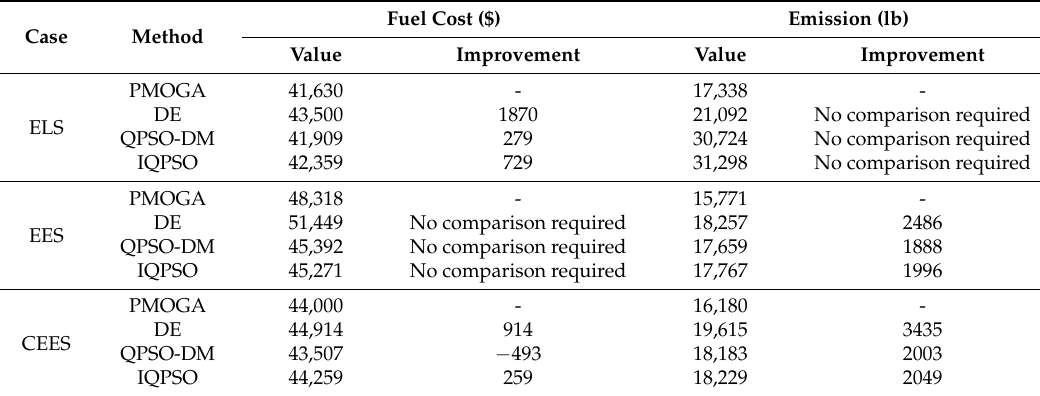
Table 5. Comparison of solutions by PMOGA and other methods for case 2. ELS: economic load scheduling; EES: economic emission scheduling; CEES: combined economic emission scheduling; DE: differential evolution; QPSO-DM: quantum-behaved particle swarm optimization with differential mutation; and IQPSO: improved quantum-behaved particle swarm